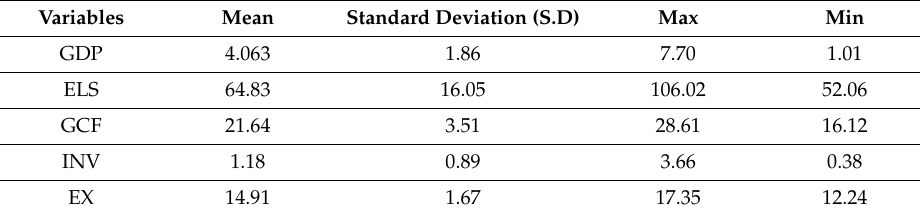
Table 3. Expressive data analysis of selected